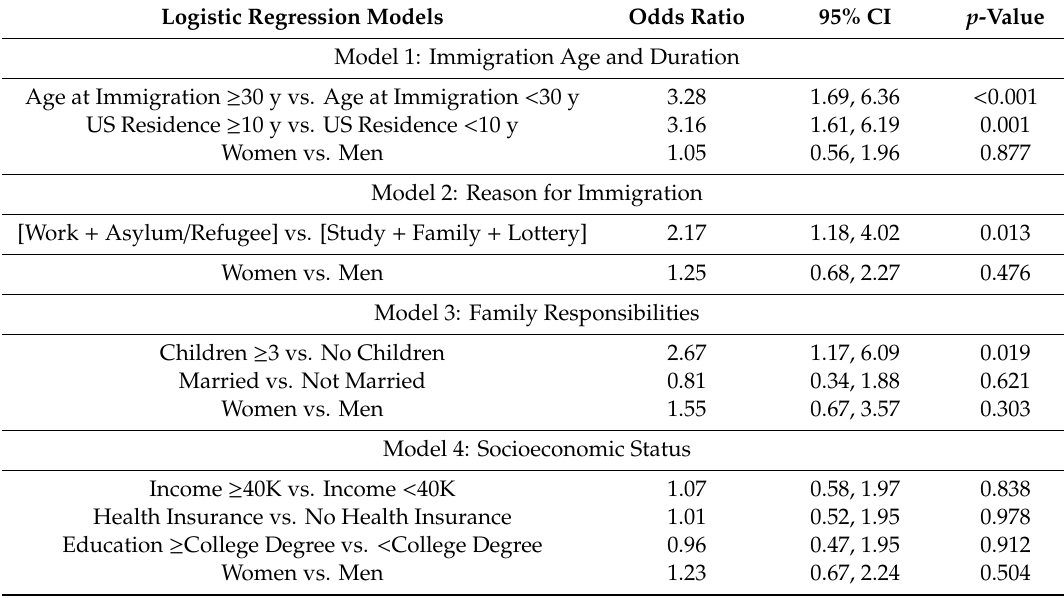
Table 3. Odds of being in the High-ALS group (Logistic